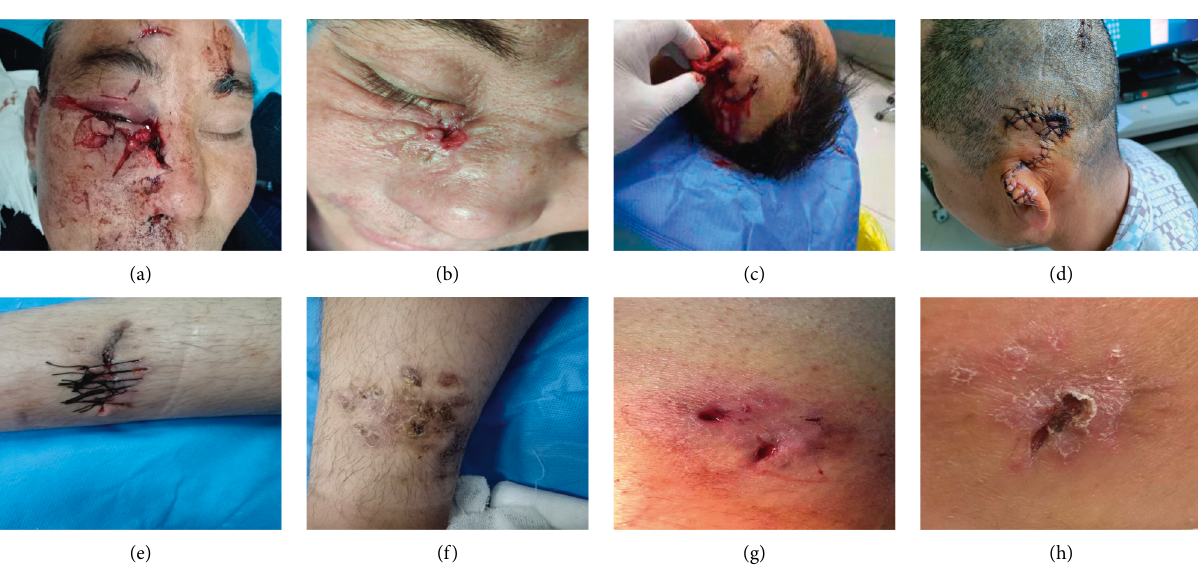
Figure 1: Recovery of patients with different treatment methods. a–d represent patients in the hyperbaric oxygen intervention group. The patients showed open injuries (a, c) and healed well after intervention (b, d); e–h represent patients in the general treatment control group. The injured parts (e, g) of the patients were not completely healed after treatment (f, h).